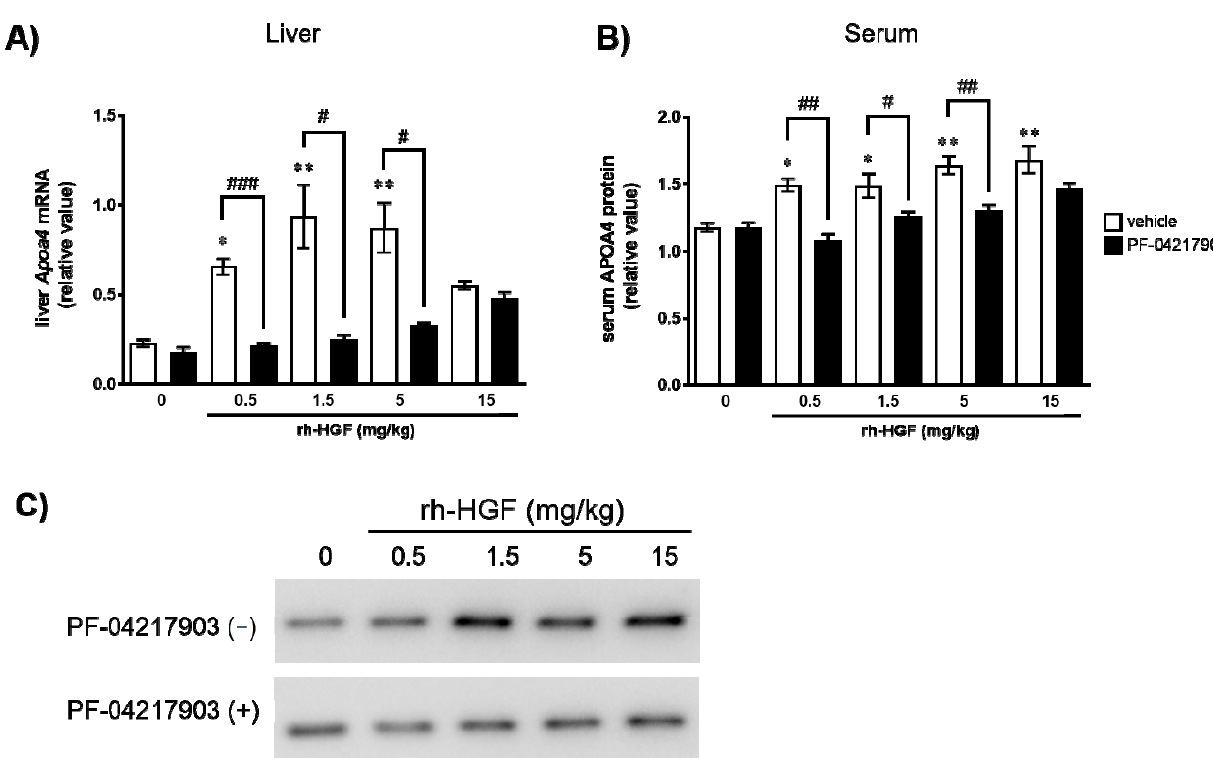
Figure 3. c-Met dependent induction of murine APOA4. Twenty-four hours after rh-HGF administration with or without PF-04217903 treatment, the mice were sacrificed, and their livers and bloods were collected for the analyses. ( A ) Relative expression of Apoa4 mRNA in the liver compared with the expression of Hprt mRNA in mice, ( B ) Relative value of APOA4 protein in serum * p < 0.05, ** p < 0.01: comparison between vehicle control (PBS) and rh-HGF alone-treated groups (Dunnett’s test), # p < 0.05, ## p < 0.01, ### p < 0.001: comparison between rh-HGF alone-treated group and PF-04217903- rh-HGF co-administered group (unpaired t test). The data are presented as mean ± SEM (n = 3). The median value of the triplicate analyses was used for calculation. ( C ) Analysis of APOA4 protein levels in serum using Western blot. The picture shows a representative image of lanes showing individual animals.